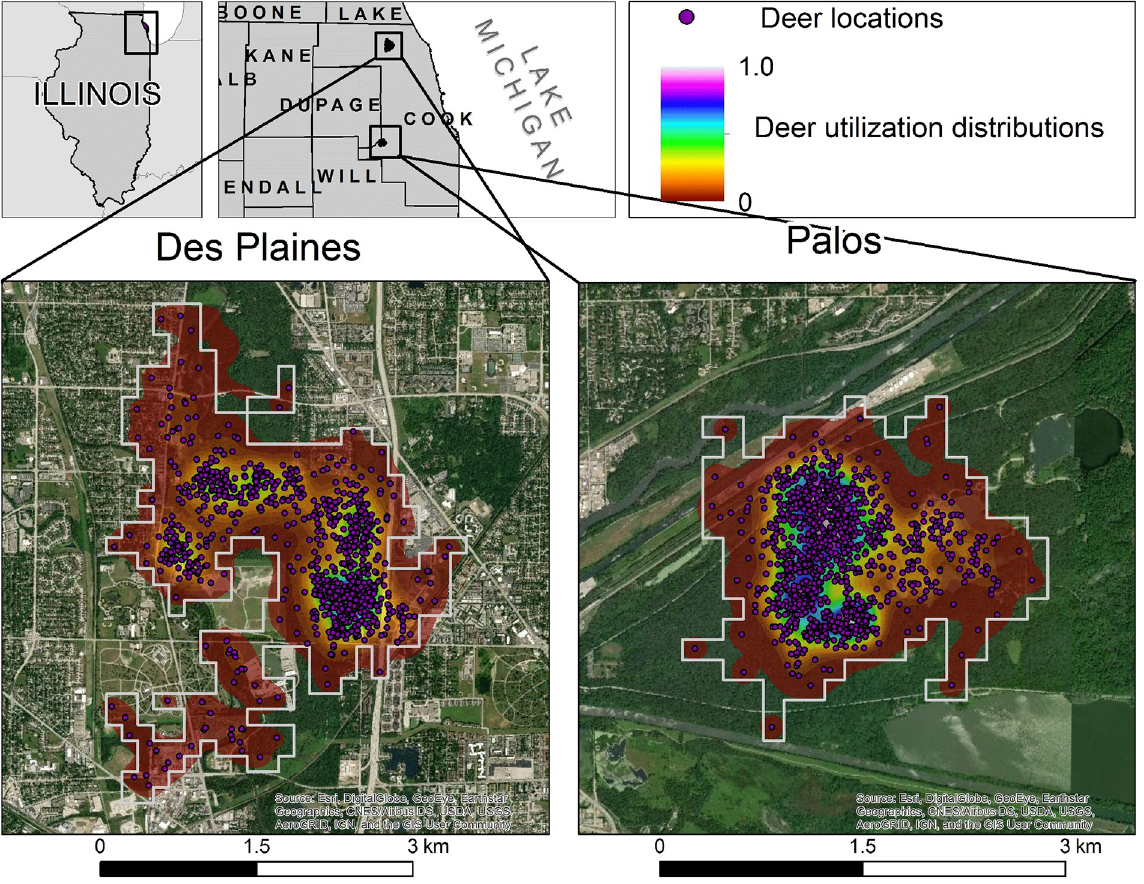
Fig 1. Distribution of the study areas for assessing the resource selection of deer in Cook County, Illinois (1996–1999).